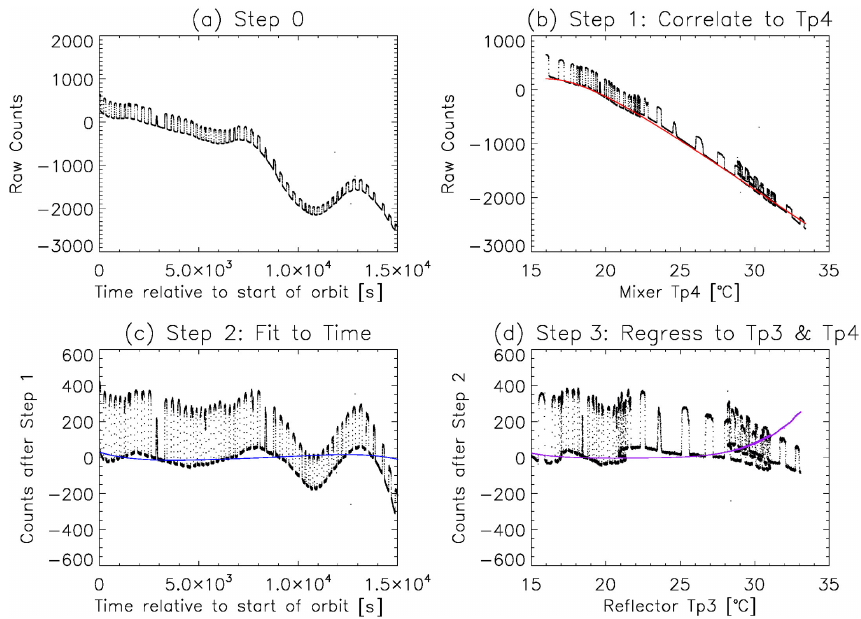
Figure B1. Same with Fig. 2, except this is an example showing a bad-quality orbit. This orbit is the second orbit of IceCube on 2 April 2018.